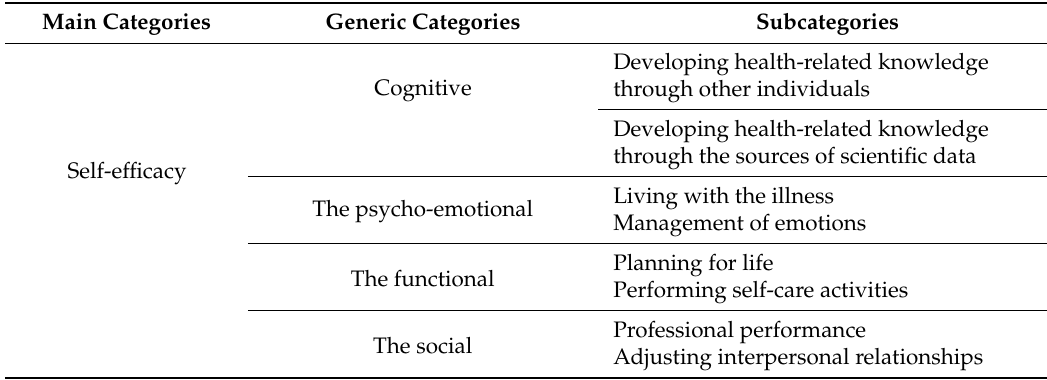
Table 2. The main categories, generic categories, and subcategories of the